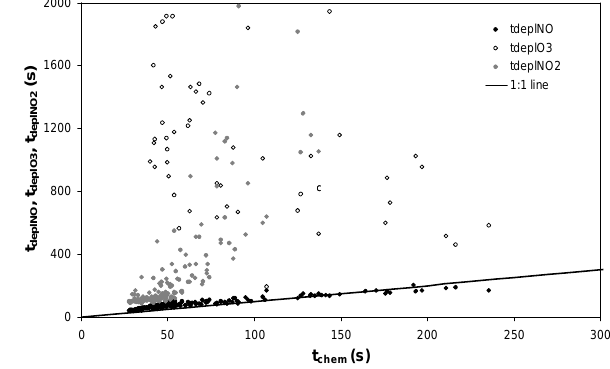
Figure 7: Comparison between chemical reaction time for the set of chemical reactions of the 15 Fig. 7. Comparison between chemical reaction time for the set of NO-O 3 -NO 2 triad ( τ chem ) and chemical depletion times for NO (black symbols), O 3 (open 16 chemical reactions of the NO-O 3 -NO 2 triad ( τ chem ) and chemical symbols) and NO 2 (grey symbols). The black line corresponds to the 1:1 line. 17 depletion times for NO (black symbols), O 3 (open symbols) and NO 2 (grey symbols). The black line corresponds to the 1:1